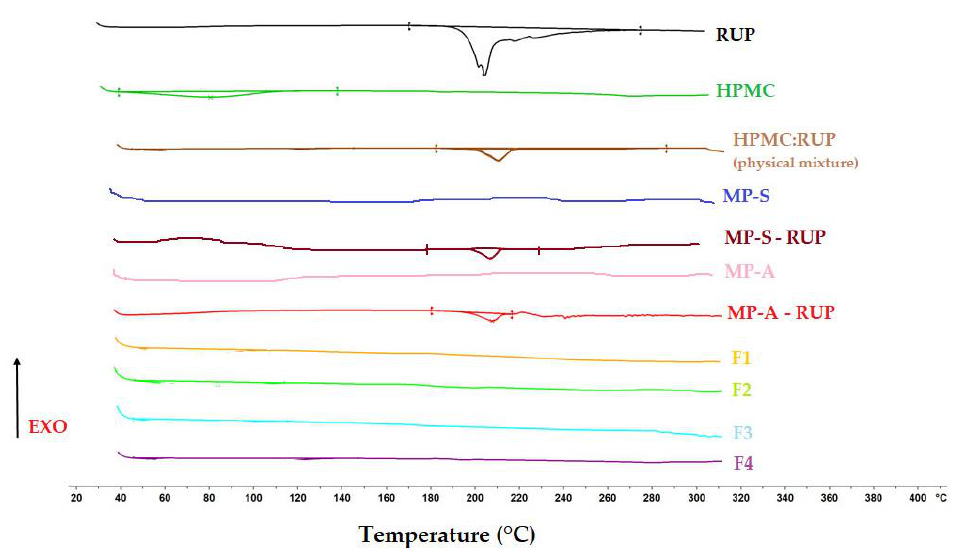
Figure 2. DSC thermograms of RUP; HPMC; physical mixture of RUP and HPMC; MPs placebo, MP-S-RUP and MP-A-RUP; and films F1, F2, F3 and F4. Palatability is of great importance to determine the drug acceptability for patients. It is valid to assess taste early on during development. Many taste-masking strategies are avail- able, among others emulsification/solvent evaporation, centrifugal extrusion, coacervation, spray drying or supercritical carbon dioxide (scCO2) assisted technique, which main advan- tage lies in the possibility of achieving a high separation of the supercritical solvent and the processed products, involved drug particle size reduction or the modification of some of the physicochemical and structural properties, especially of poorly water-soluble drugs [47–50]. While utilising the spray drying technique, the bitter drug is dissolved or dispersed along product contains particles incorporating taste- and flavor-masked drugs. This method provides an alternative route to taste-masking by providing a physical barrier coating